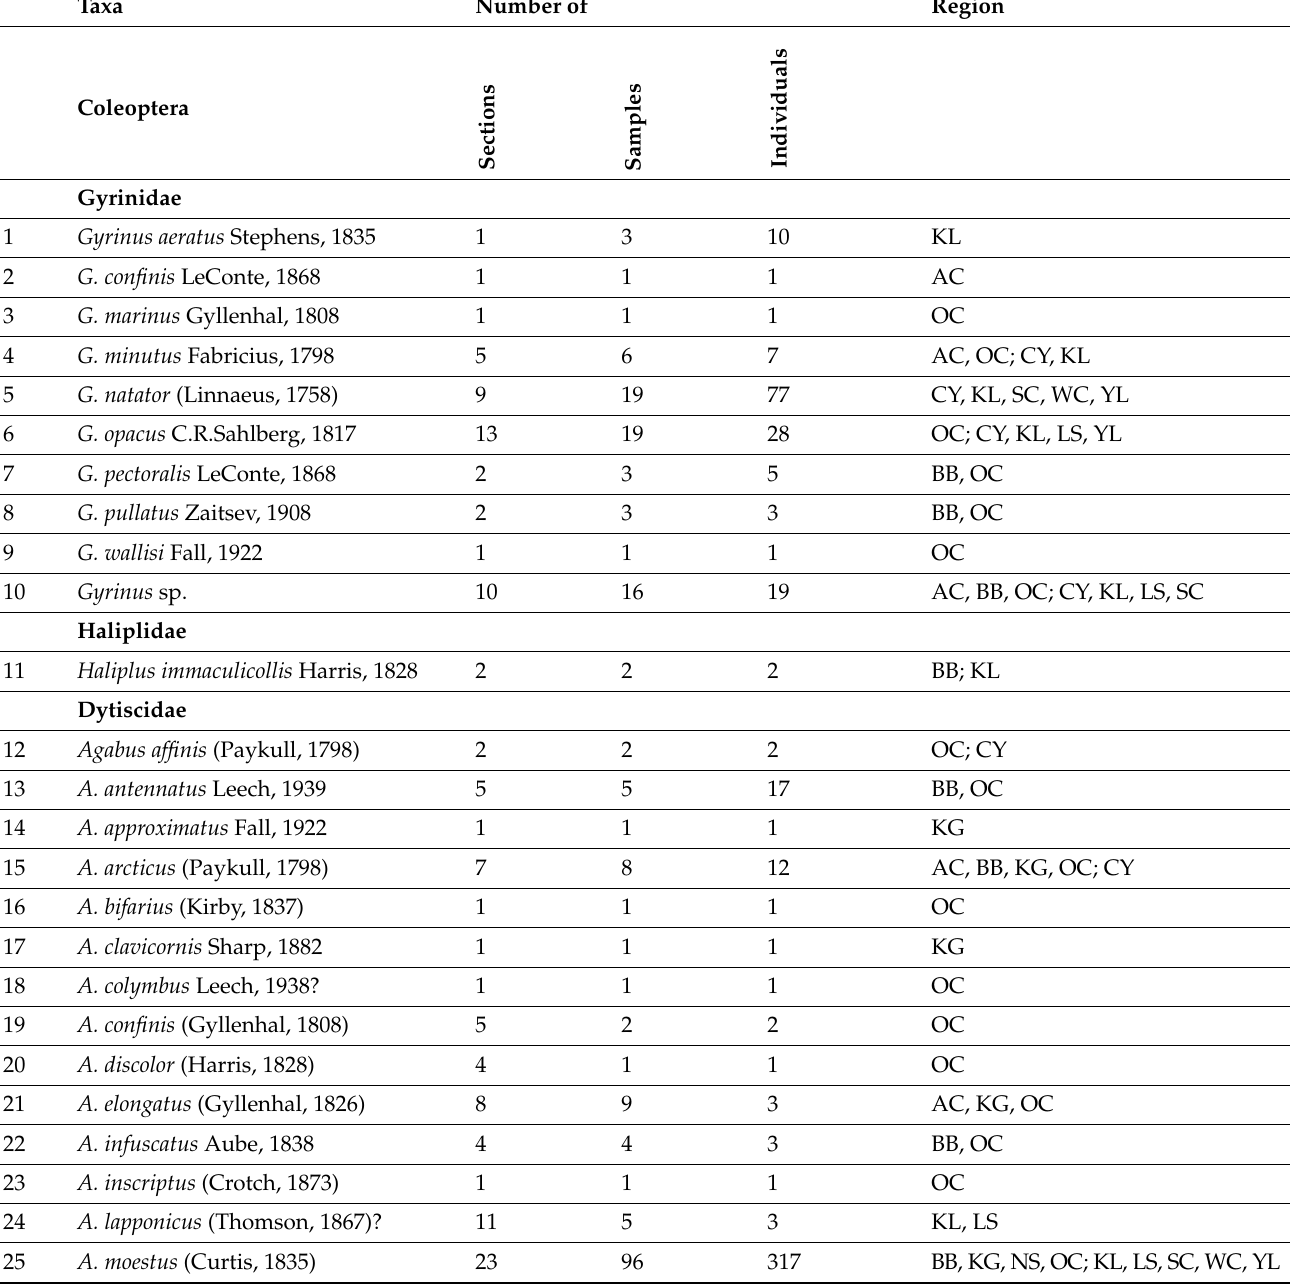
Table 1. List of aquatic beetles from Quaternary deposit of